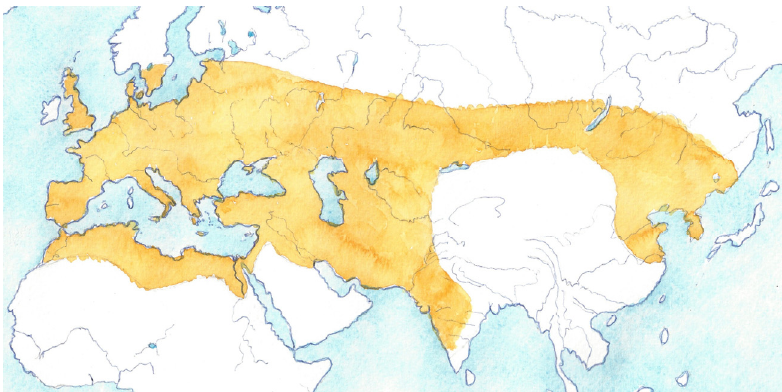
Figure 2. Distribution of Bos primigenius ca. 12.000 BP [16,17] (Map by Marleen Felius).